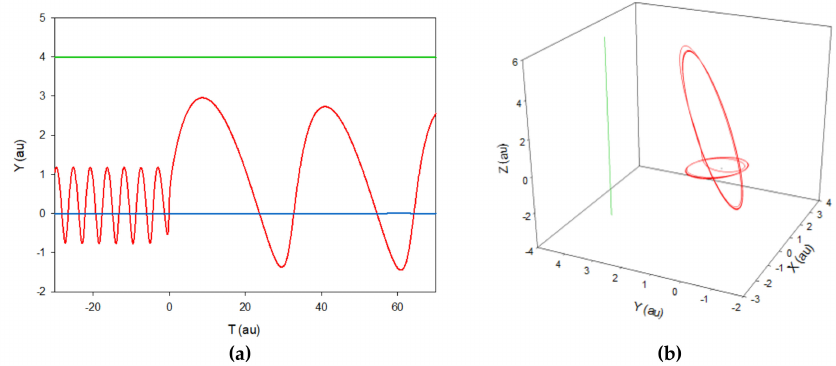
Figure 6. ( a ) y position trajectory as a function of time in the lab frame, ( b ) 3D trajectory in the lab frame for the electron (red line), projectile (green line) and target (blue line) for the excitation channel 1s → 2s,2p and for Be 4 + with E = 900 keV /